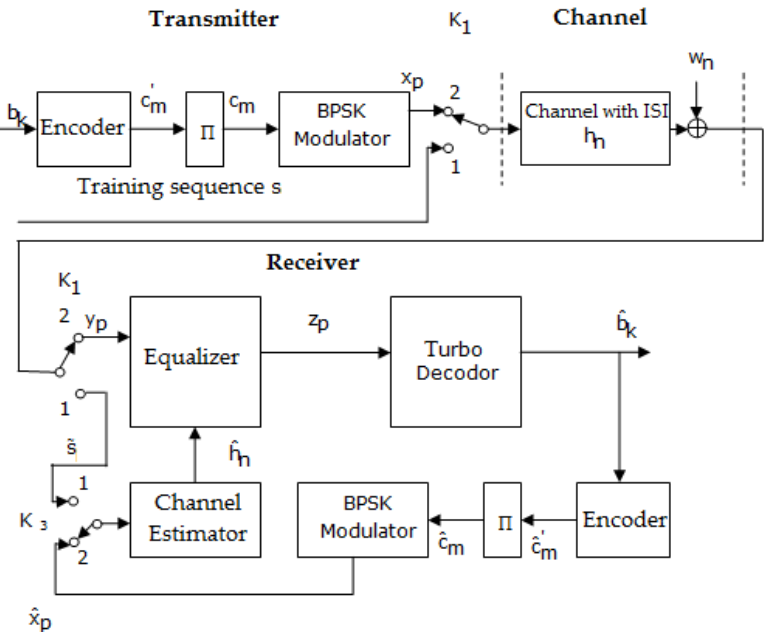
Figure 9. Block diagram of a transmission–reception system that performs the iterative estimation and the equalization of the channel at the reception, in the case of applying turbo codes [46].